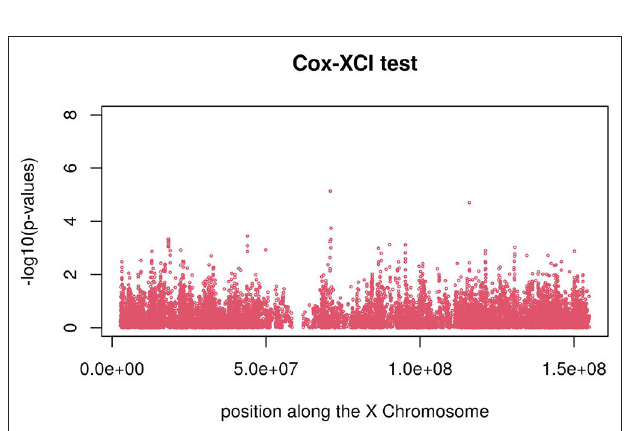
FIGURE 7 | Manhattan plot of X Chromosome genome-wide association results - Xu-Hao